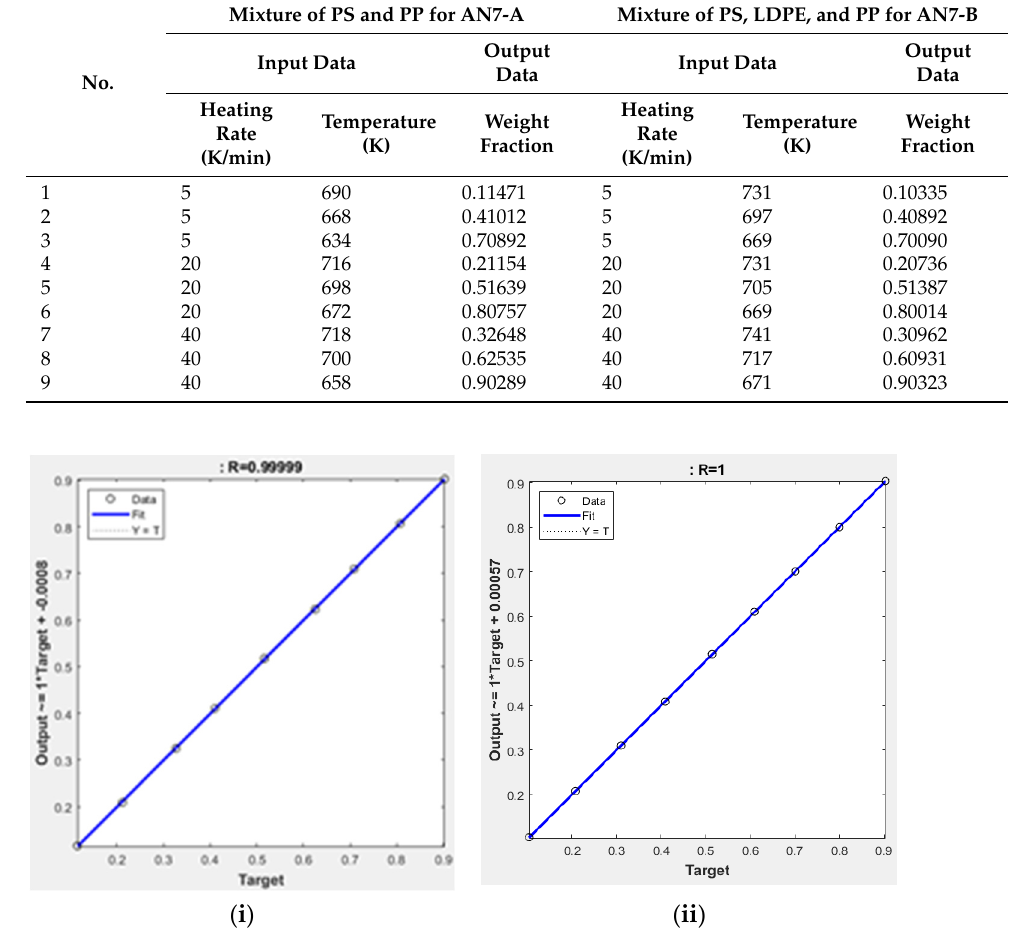
Table 7. Simulation input data and output data: mixtures of PS and PP mixtures of PS, LDPE, and PP.